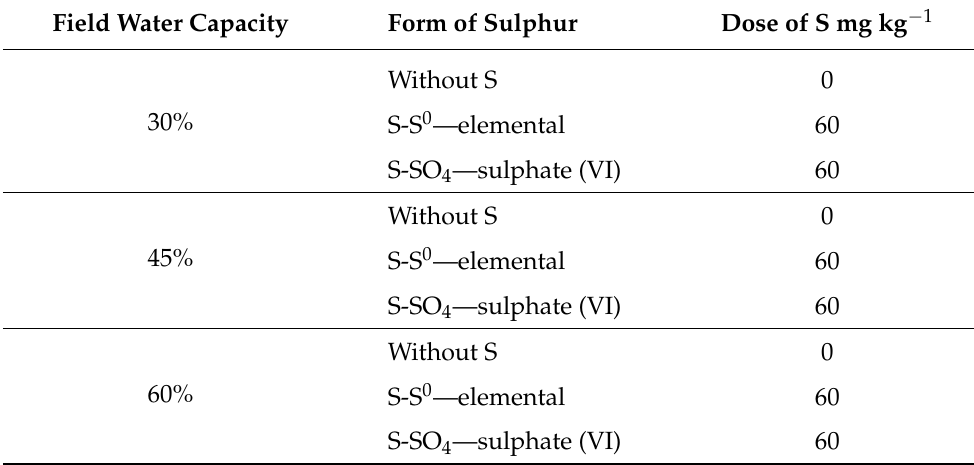
Table 2. Treatments in the pot